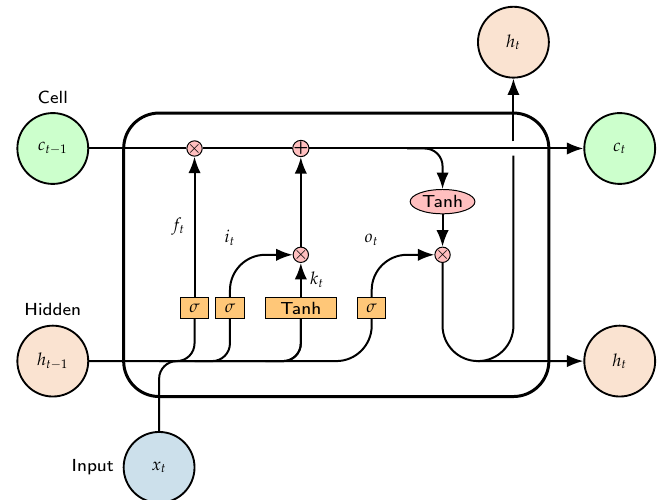
Figure 3. LSTM network